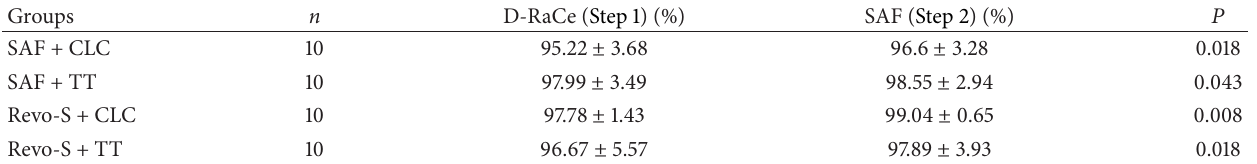
Table 1: Percentages of removed filling material from root canals after retreatment (mean ± standard deviation).